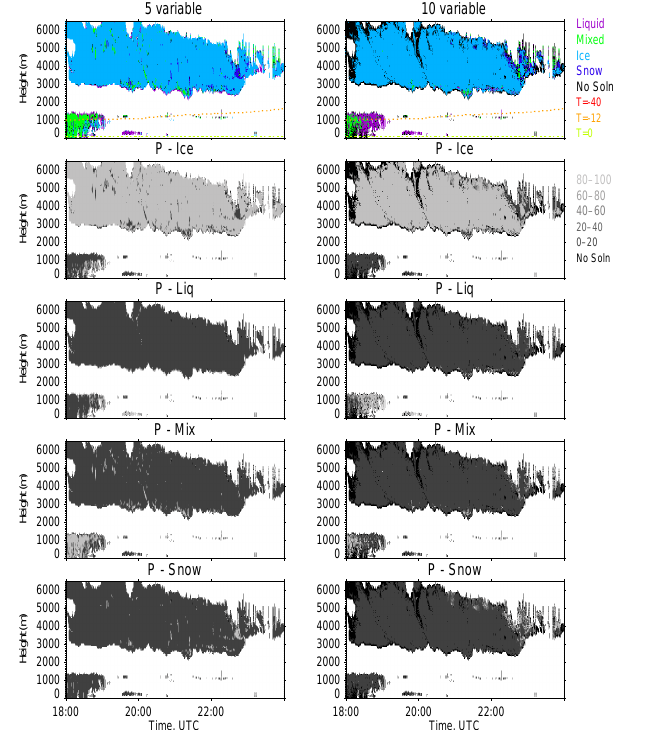
Figure 10. Application of 5-variable (left) and 10-variable (right) phase algorithms to 1 October 2004 test case. Color panels show algorithm identification when probability of a given phase is greater than 60%. Gray-scale figures show probabilities of a given phase in